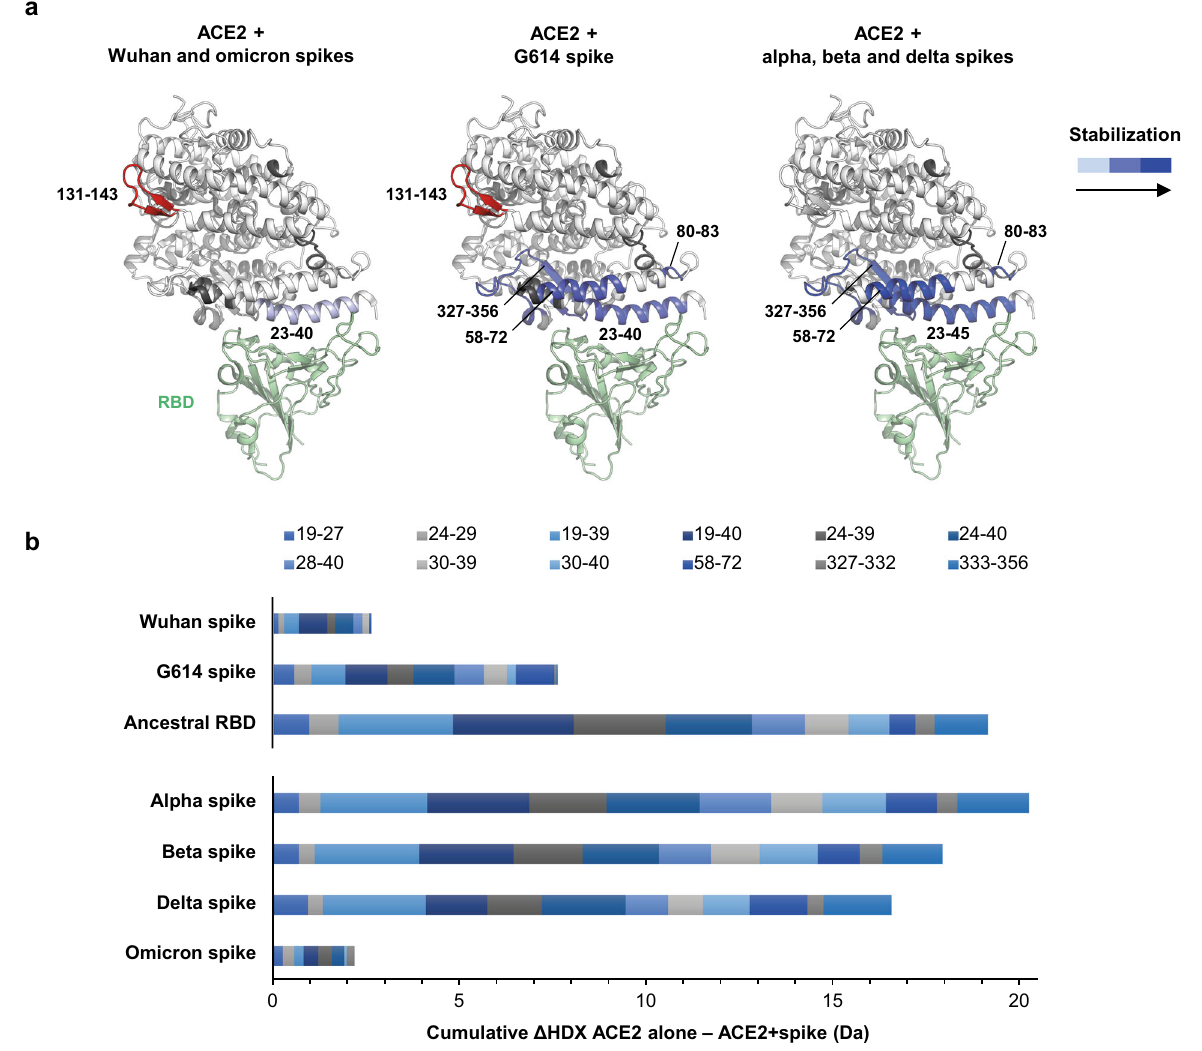
Fig.3| EffectofspikebindingonACE2dynamics.a Regionsof ACE2manifesting a signi fi cant decrease in HDX upon spike binding are superimposed on the struc- ture of ACE2 ectodomain bound to RBD (PDB: 2ajf), coloured in blue scale accordingtothemagnitudeoftheHDXeffect.Theregioncolouredinredindicates increased HDX upon binding, in dark grey regions with no coverage. b ACE2